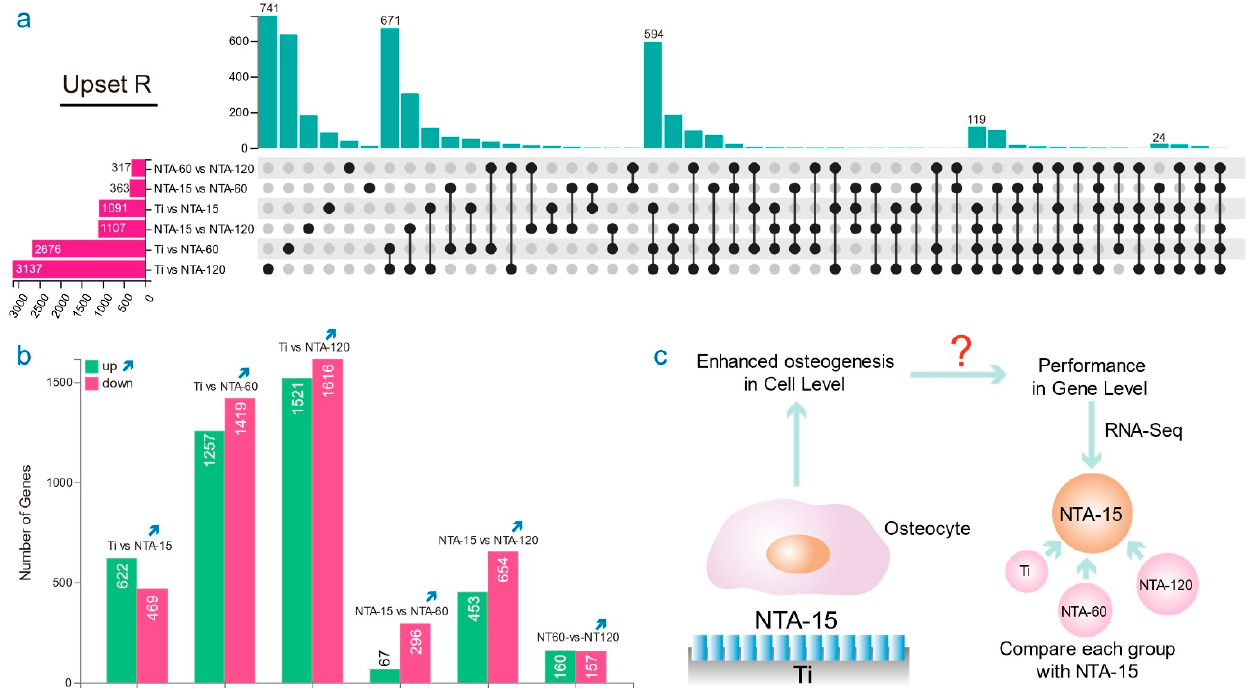
Figure 4. RNA-Seq results of osteocytes cultured on Ti and TNAs. ( a ) Upset R analysis of differential genes among groups. ( b ) The numbers of up-/downregulated genes among the comparison. ( c ) Illustration of the following framework of gene analysis.